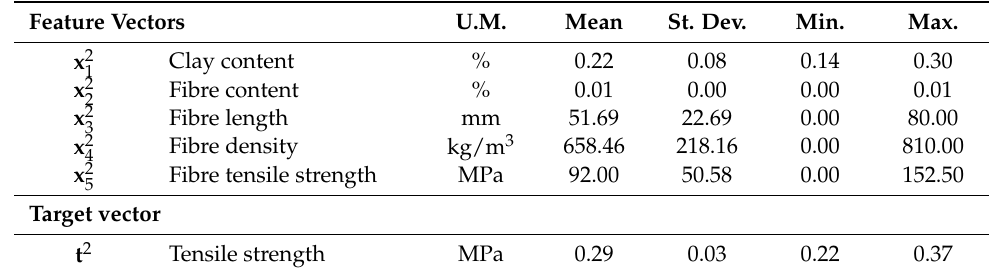
Table 4. Descriptive statistics of the features of Database 2.